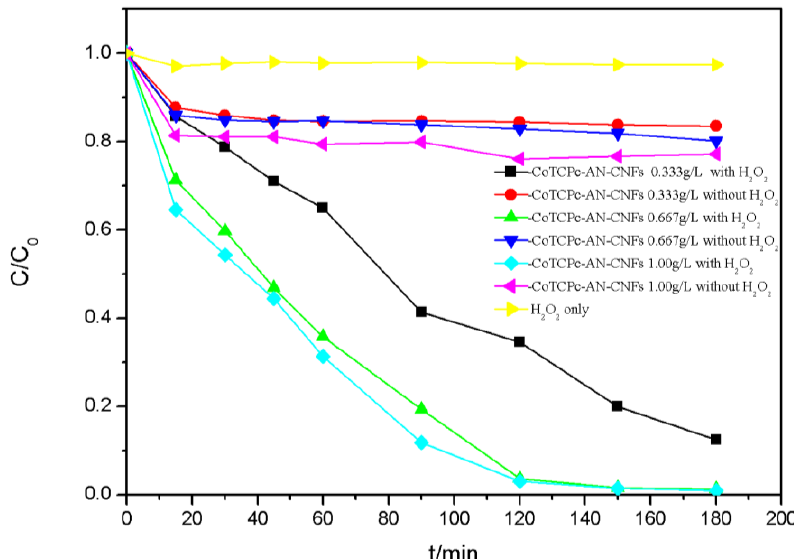
O ) = 4.85 × 10 −2 mol/L, 25 2 2